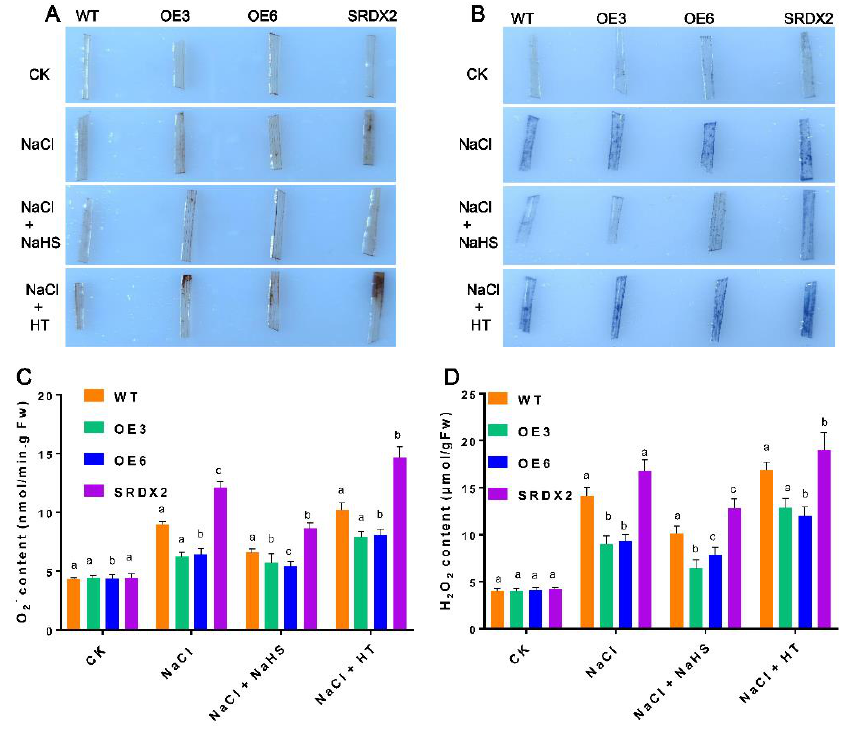
Figure 11. Effects of NaHS and hypotaurine (HT) on ROS content in WT and transgenic lines under salt stress. ( A ) DAB staining. ( B ) NBT staining. ( C ) O 2 − content. ( D ) H 2 O 2 content. The 14-day-old seedlings were pretreated with or without NaHS (100 μM) and HT (2 mM) for 6 h, and then shifted to a 1/2 Murashige and Skoog (MS) solution with or without NaCl (200 mM) for another 48 h. Seedlings without chemical treatment were regarded as the control check (CK). Values are means ± SE of three independent experiments with at least three replicates for each. Statistical analyses were performed by a two-way ANOVA, followed by a Tukey’s multiple comparison test. Different letters indicate significant differences at p < 0.05.